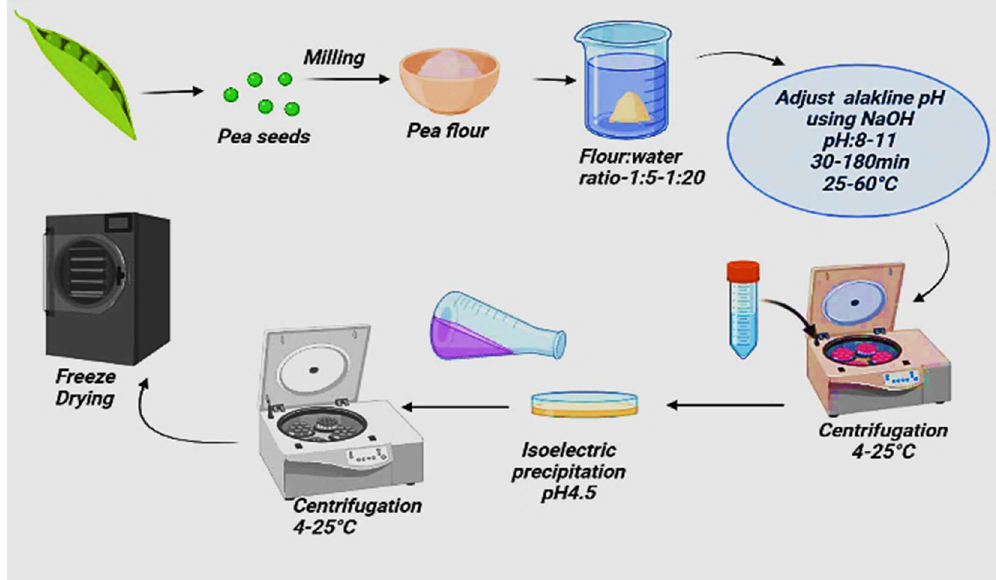
Figure 1. Extraction of pea protein by alkali extraction/isoelectric precipitation.